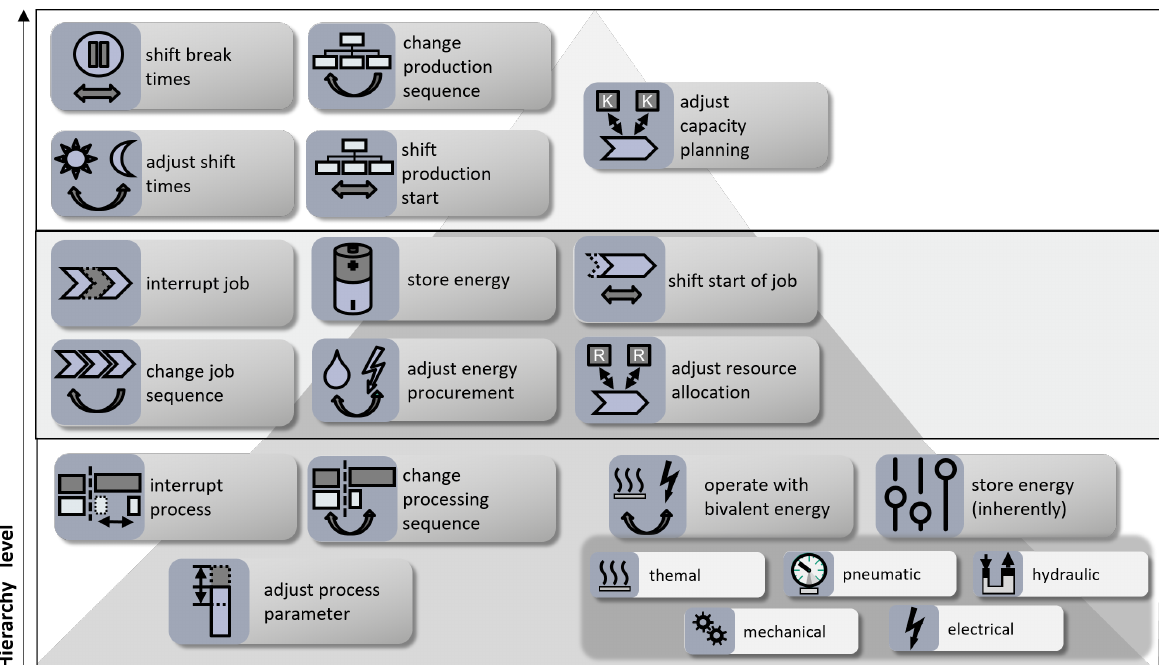
Figure 2. Categories of DR measures by the authors of